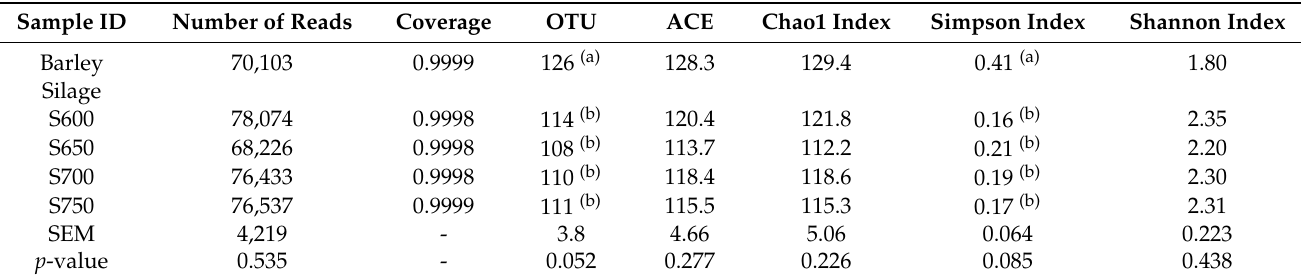
Table 2. Number of reads and coverage of 16S rDNA and measures of bacterial diversity generated from the DNA data for fresh barley and silages of various densities ( n = 3).